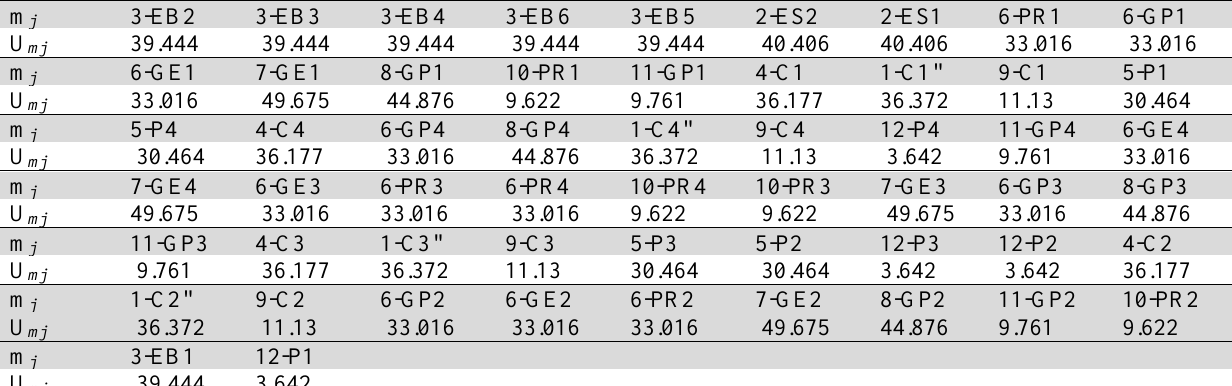
Results of optimal sequence of operation and associated cutting speeds of Case 2 using PSO m j